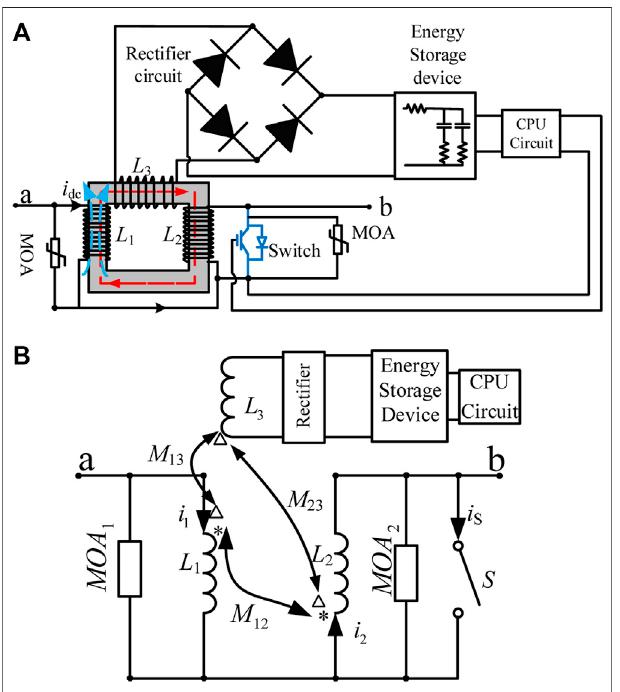
FIGURE4| StructureoftheSCCSSFCLwithSPSS. (A) Con fi gurationof the SCCSSFCL with SPSS. (B) Equivalent circuit of the SCCSSFCL with SPSS.